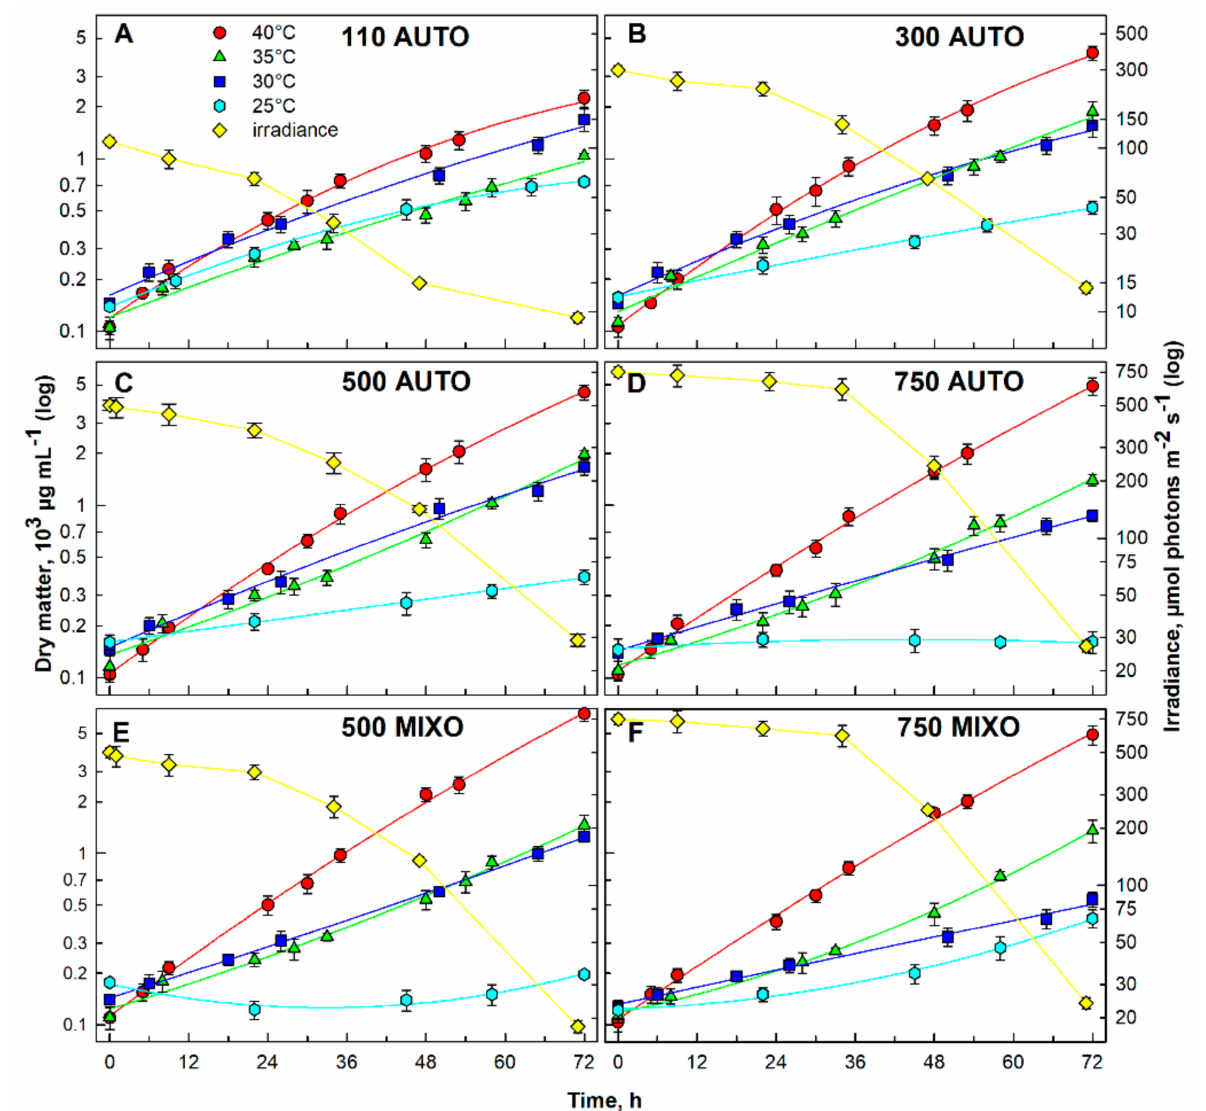
Figure 1. The growth of the Galdieria sulphuraria under auto- (panels ( A – D ), AUTO) and mixotrophic (panels ( E , F ), MIXO) regimes at different starting irradiances in the center of the cultivation cylinder (110, 300, 500 and 750 µ mol photons m − 2 s − 1 , indicated in each panel) and different temperatures (40 ◦ C-red circles, 35 ◦ C-green triangles, 30 ◦ C-dark blue squares, and 25 ◦ C-cyan hexagons). The irradiance in the center of cultivation cylinders declining with increasing cell density during the cultivation is indicated in each panel (yellow diamonds). Growth is expressed as dry matter (DM) in µ g mL − 1 . The data are plotted as means of biological triplicates. The error bars represent standard deviations ( ± SD) and are shown when larger than the symbol